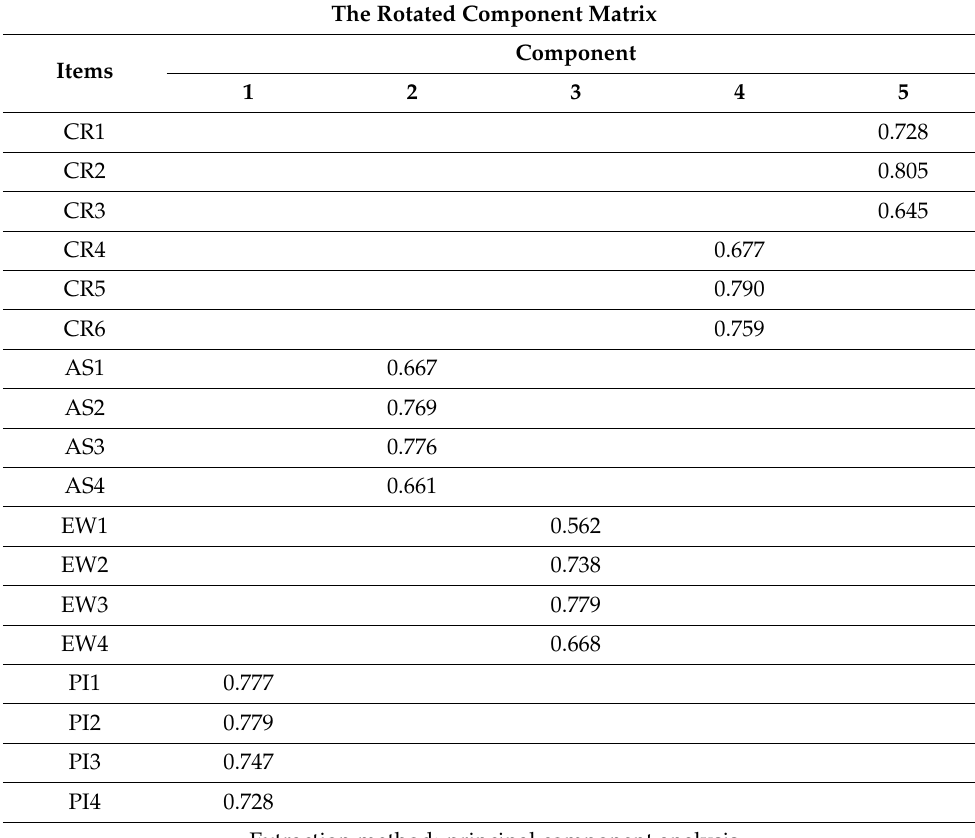
Table 4. The rotated component